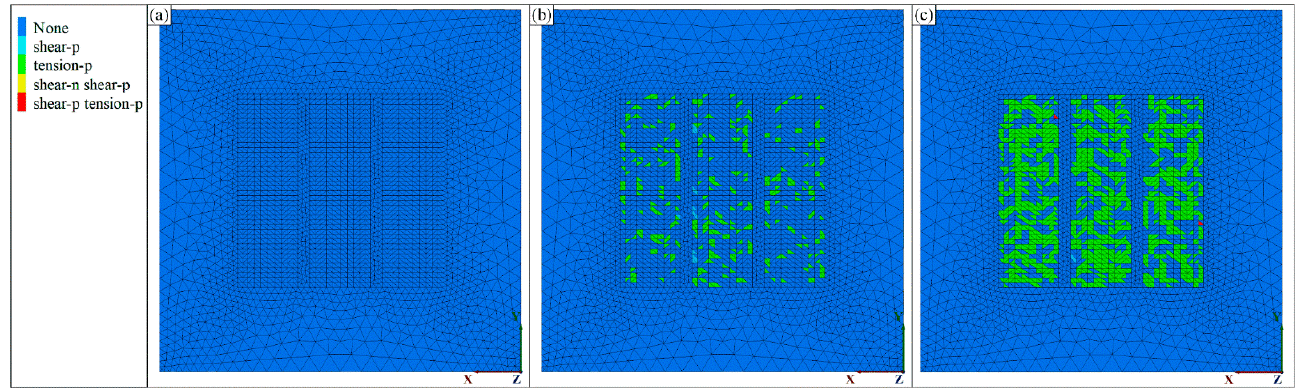
Figure 8. Distribution of Z-direction displacement: ( a ) non-mining condition; ( b ) normal backfilling condition; ( c ) non- backfilling condition.